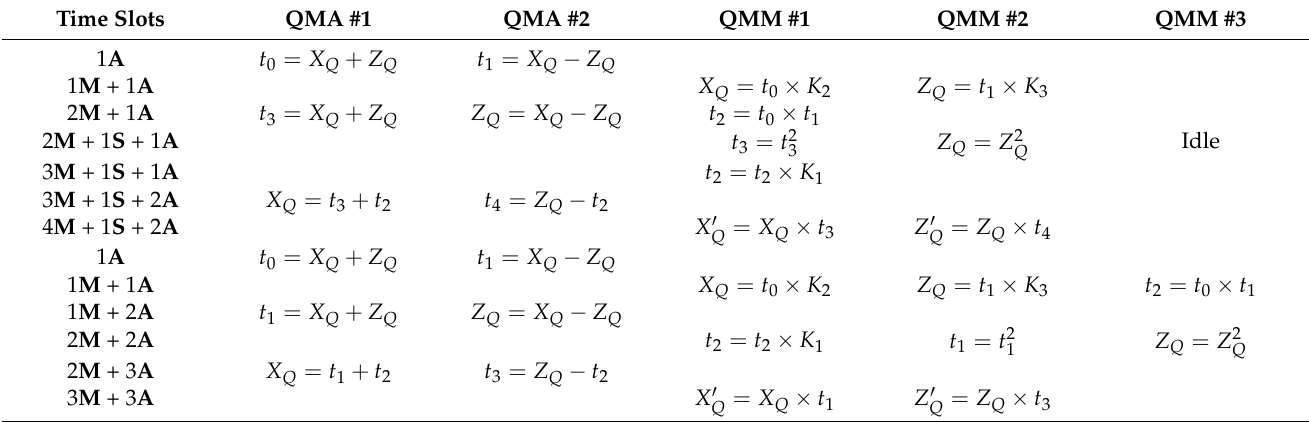
Table 3. Comparison of a 4-isogeny evaluation with two and three quadratic modular